Question: What caption would you write for this figure?
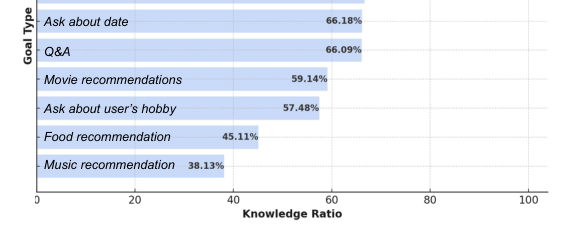
Answer: Knowledge ratio for each goal type on DuRec- Dial. (X-axis: Knowledge Ratio ; Y-axis: Goal type)